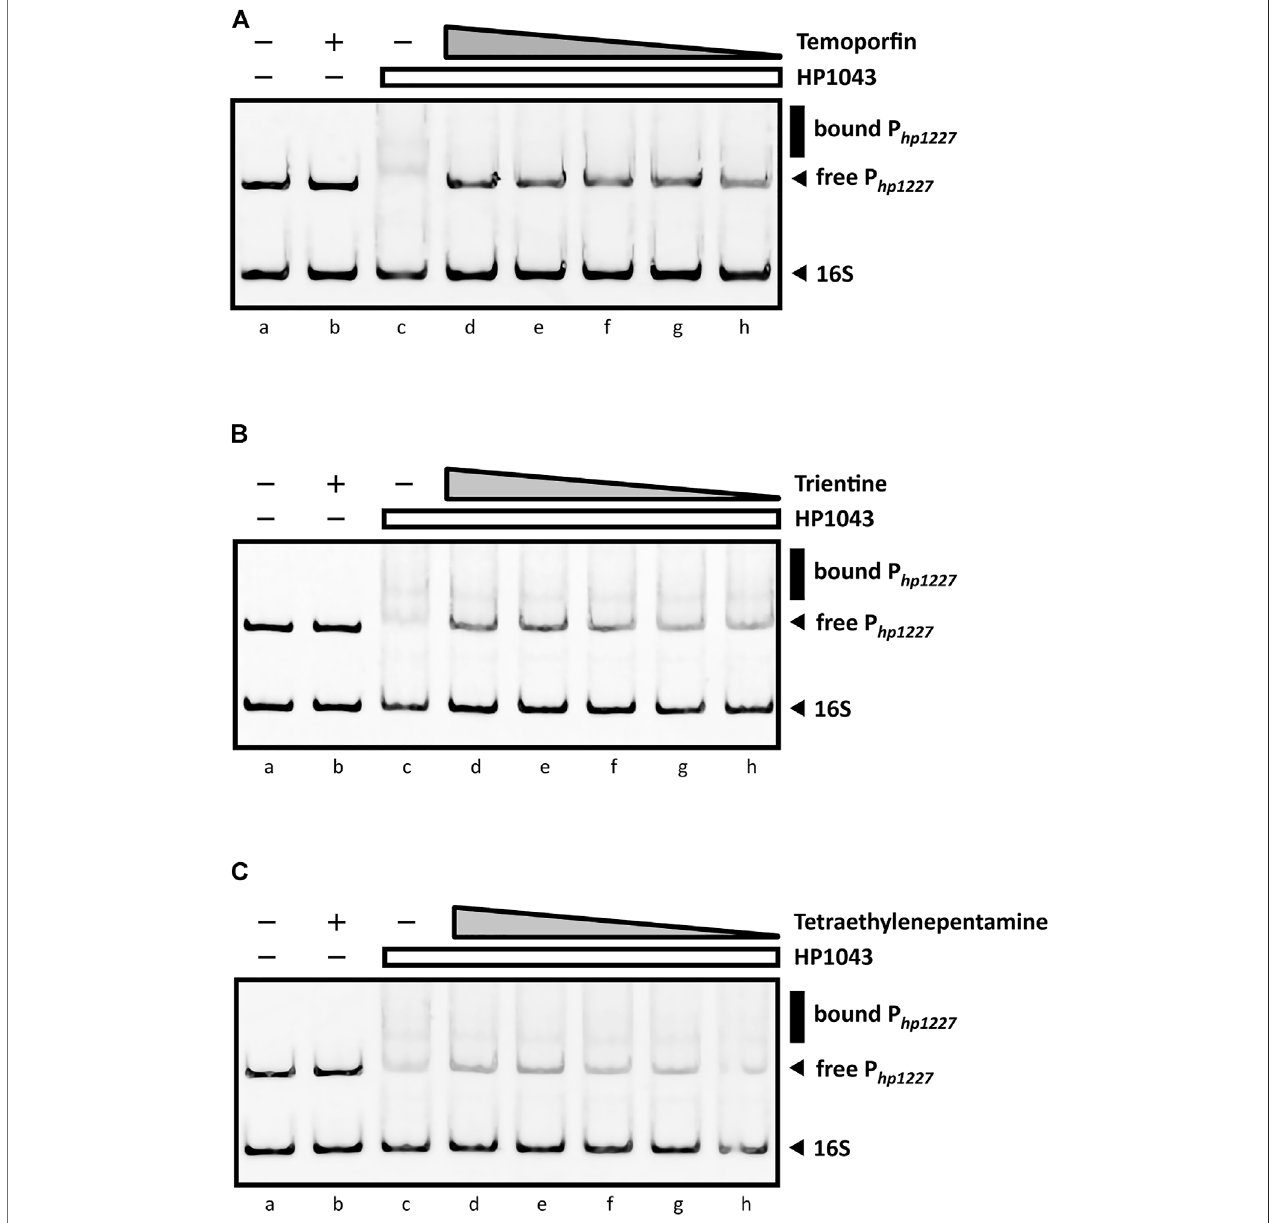
FIGURE 8 | EMSAs in the presence of DNA-binding inhibitors. All EMSAs show the same amount of speci fi c (P hp1227 ) and non-speci fi c (16S rRNA gene) DNA probesandthesamesampleorder:lane(a)DNAprobescontrol,protein-andligand-free;(b)compoundcontrolat1 mM(indicatedbya “ + ” )withouttheprotein;(c)DNA- bindingcontrolinthepresenceofHP1043;lane(d)to(h)showsamplescontaininga fi xedamountofHP1043monomericprotein(4 μ M)withadecreasingconcentration oftheligand,respectively,1,0.5,0.2,0.1,and0.05 mM;theabsenceofproteinandcompoundisindicatedbya “ − ” ;thecompoundconcentrationisdepictedasa gray triangle, while a whiterectangle is used for the HP1043 protein fi xed concentration. (A) Addition oftemopor fi n results in areduced in vitro af fi nity ofHP1043 protein for its target promoter region. Temopor fi n restored the free DNA probe mobility and reduced the smear of the speci fi c DNA probe at higher concentrations. For (B) trientine and (C) tetraethylenepentamine, similar inhibition effects were observed. Both chemicals induced a decreased DNA-binding activity for HP1043. However, a faint up-shifted band is still visible with the tested conditions. Symbols are as described in the legend in Figure 7